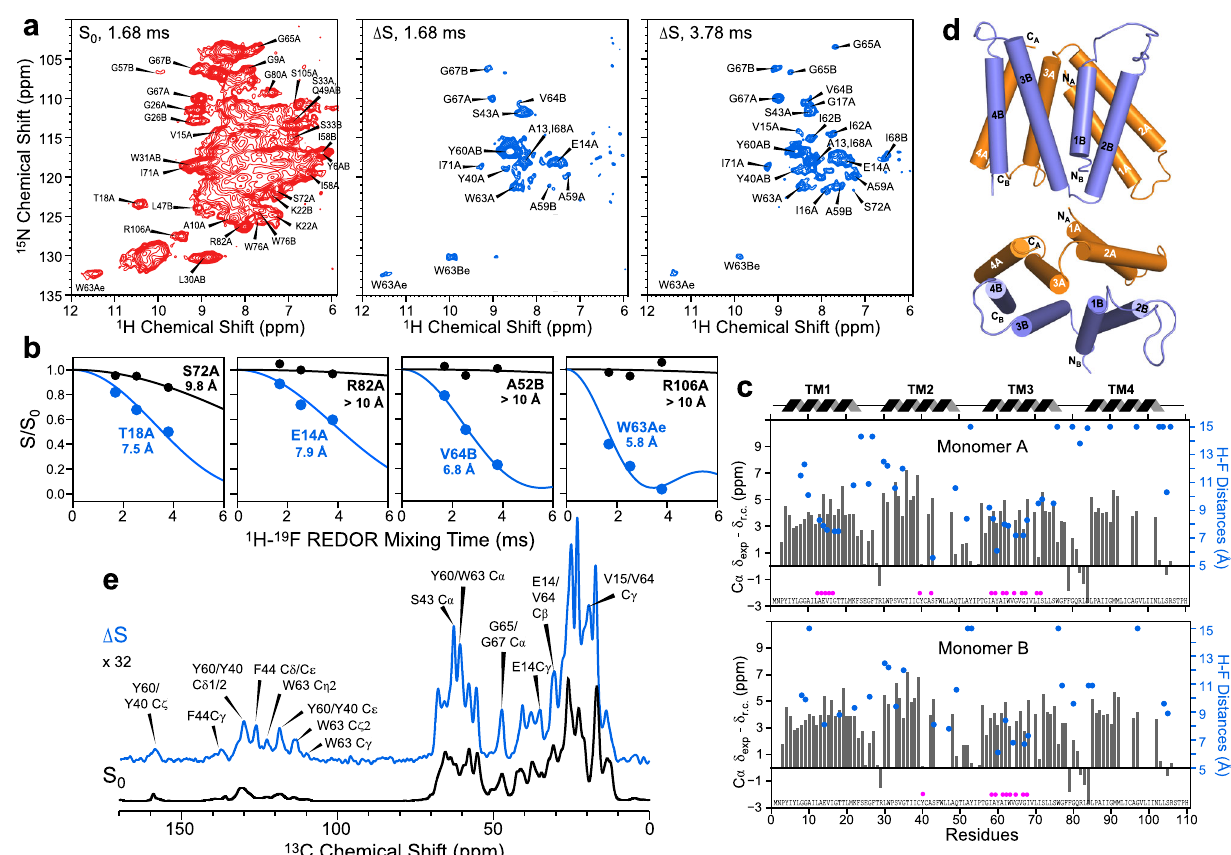
Fig. 4 Protein – substrate distance measurement using 1 H- 19 F and 13 C- 19 F REDOR experiments. a Representative S 0 (red) and Δ S (blue) 2D REDOR-hNH correlation spectra, measured with mixing times of 1.68 ms and 3.78 ms. Assignment is shown for selected peaks in the S 0 spectrum. More difference peaks are observed in the 3.78 ms Δ S spectrum than the 1.68 ms Δ S spectrum due to the detection of H N sites further away from the substrate at longer mixing times. b Representative 1 H- 19 F REDOR S/S 0 dephasing curves with best- fi t simulations. Fast and slow dephasing, corresponding to short and long distances, are shown in blue and black, respectively. c C α secondary chemical shifts (gray bars) of F 4 -TPP + bound EmrE, indicating the four TM α -helices separated by short loops. Residues whose H N atoms show difference signals in the 2D REDOR-hNH spectra are indicated by magenta circles at the bottom. Best- fi t H N -F distances are indicated by blue circles. Residues in TM3A, TM3B, and TM1A display short distances to F 4 -TPP + . d Topology of the eight TM helices in the dimeric EmrE, with monomer A helices shown in orange and monomer B helices shown in blue. e 1D 13 C- 19 F REDOR S 0 and Δ S spectra, coadded from spectra recorded with mixing times of 0.92, 2.0, 3.0, and 4.5 ms. The Δ S spectrum is scaled up by 32-fold with respect to the S 0 spectrum to better display the signals of substrate-proximal 13 C sites. Note the preferential increase of aromatic 13 C intensities in the 100 – 160 ppm region in the Δ S spectrum compared to the control S 0 spectrum. This is consistent with the dominance of aromatic residues at the binding site. Selected peaks are assigned based on the chemical shifts assigned from the 3D correlation spectra (Supplementary Table